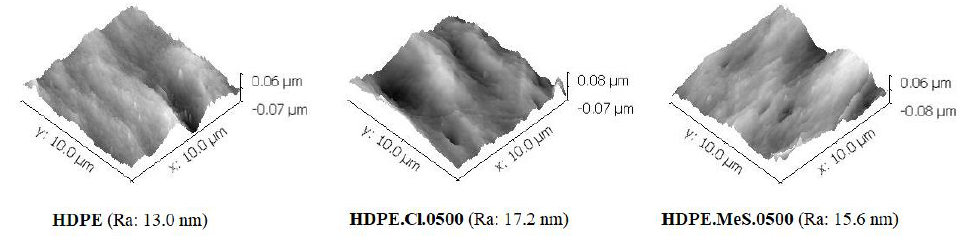
Figure 2. SEM micrographs of ( A ) HDPE, ( B ) HDPE.Cl.0500, and ( C ) HDPE.MeS.0500 (scale bar = 1 μm).